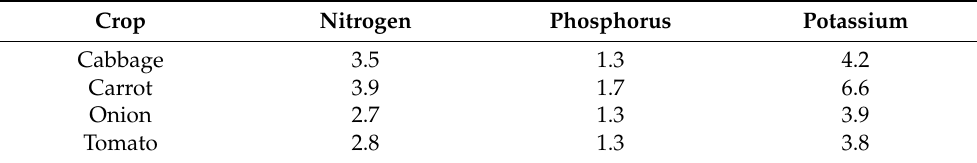
Table 1. Nutrient consumption of some popular crops (in Kg/ton).